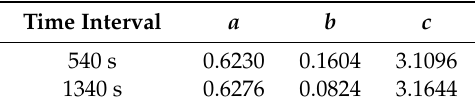
Table 3. Parameter set for the calculation of phase separation